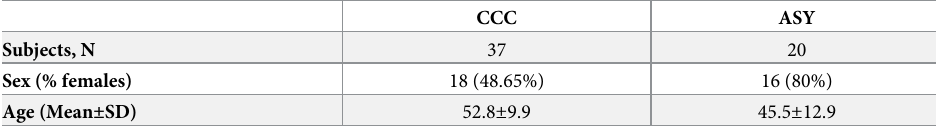
Table 1. Demographical characteristics and sample